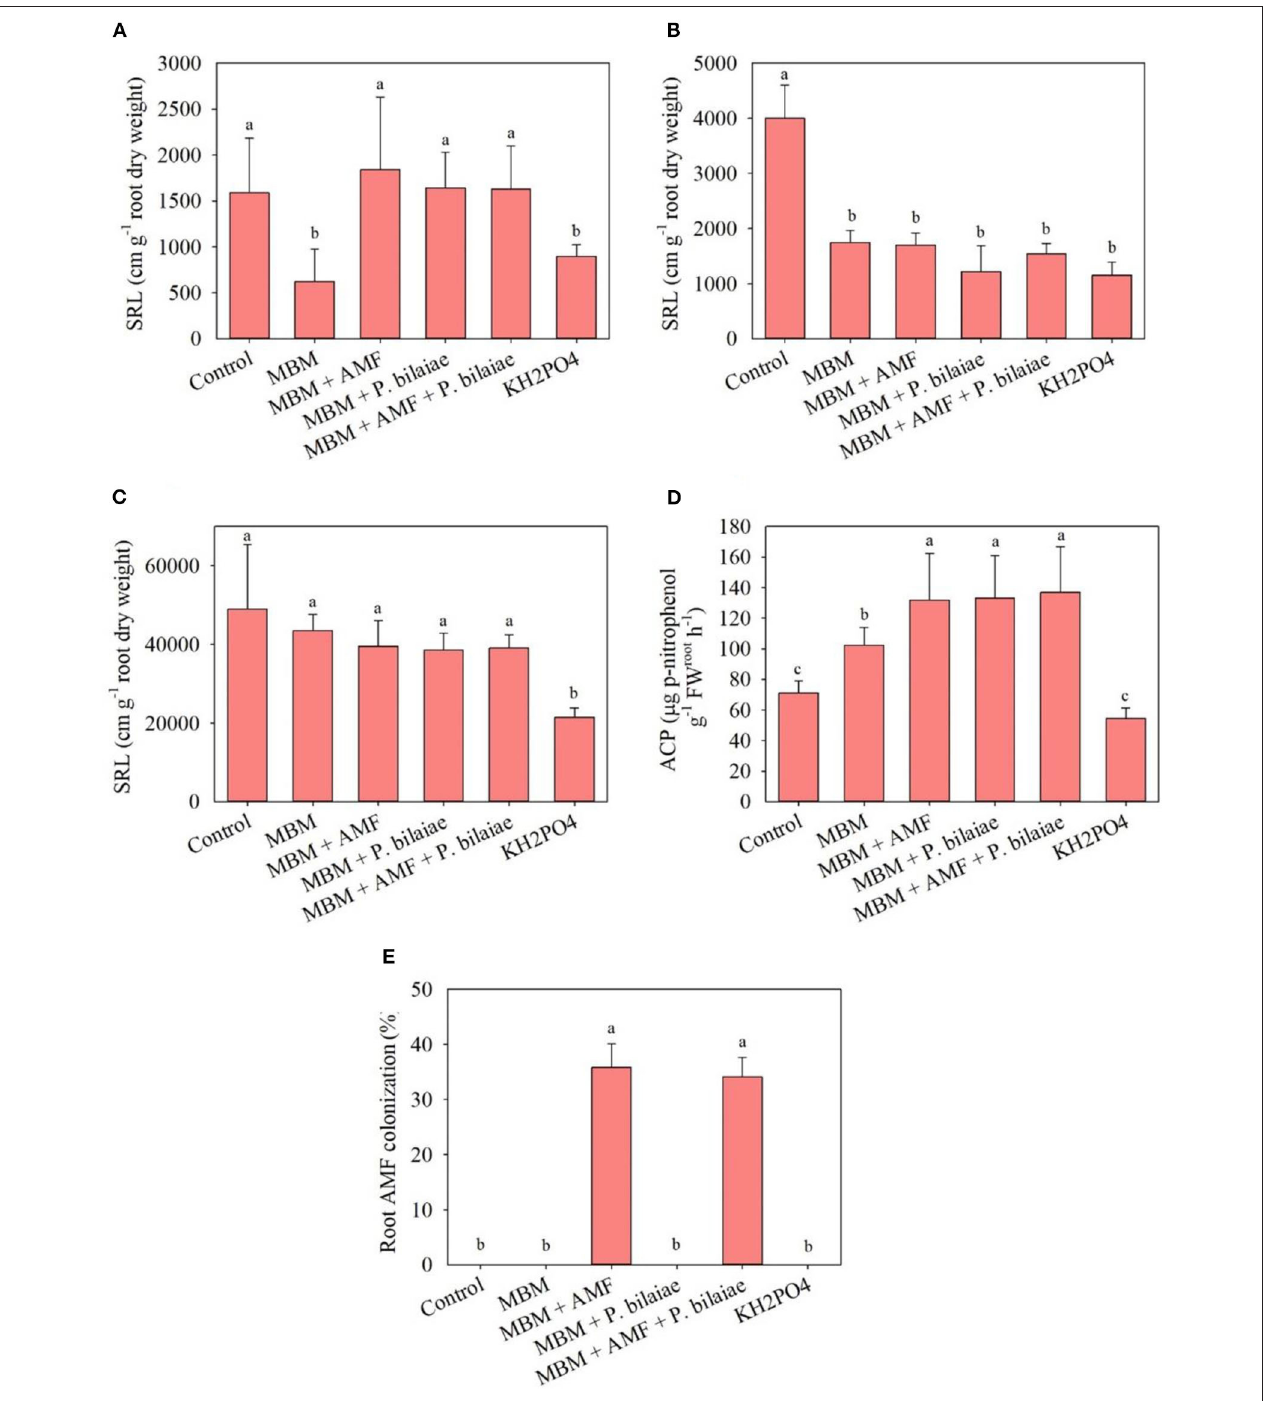
FIGURE 4 | Specific root length for primary (A) , crown (B) , lateral (C) roots, root acid phosphomonoesterase activity (D) , and percent root arbuscular mycorrhizae colonization (E) as affected by different P fertilizers and P mobilizers (arbuscular mycorrhizae fungi (AMF) and P. bilaiae ) at 40 days after planting. Different alphabetical letters signify the statistical difference (Tukey test, p < 0.05) across the treatments. Error bar represents the mean ± SD ( n = 5).